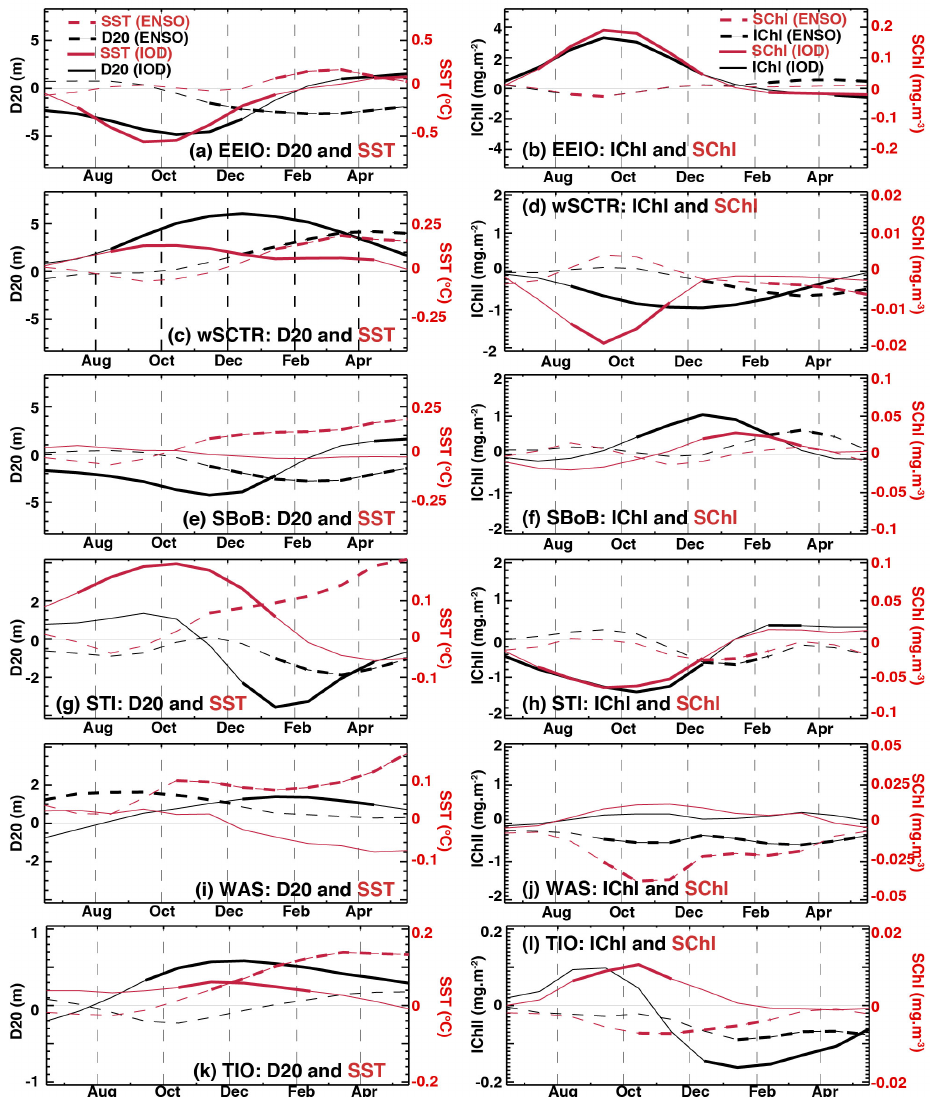
Fig. 9. Seasonal evolution of the IOD (solid) and ENSO (dashed) impacts on D20 (black) and SST (red) anomalies in the left column, and I Chl (black) and S Chl (red) anomalies in the right column, as indicated by partial regression coefficients of these anomalies regressed onto the respective climate index, having removed the influence of the second/remaining climate index (Eqs. 1–3 for solid lines; Eqs. 4–6 for dashed lines). The geographical regions are indicated on Figs. 3 and 6 and described in Sect. 2.3. Bold line segments indicate when partial regression coefficients are beyond the 90% significance